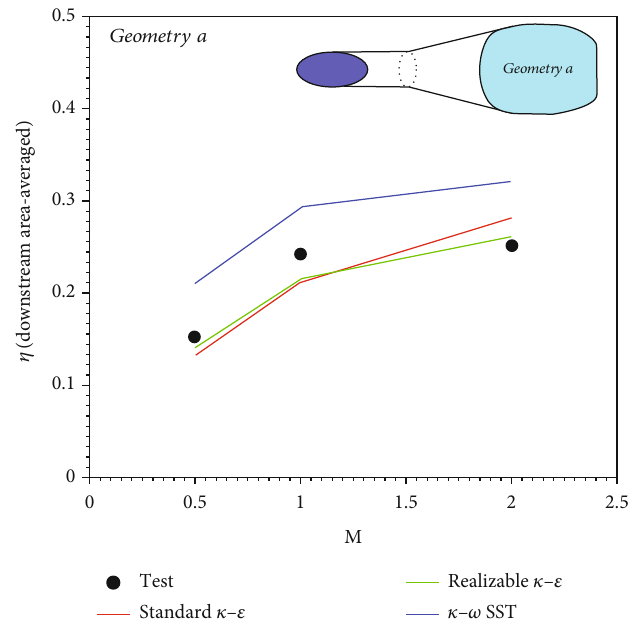
Figure 8: Comparison of di ff erent turbulence models with the test data for Geometry a.